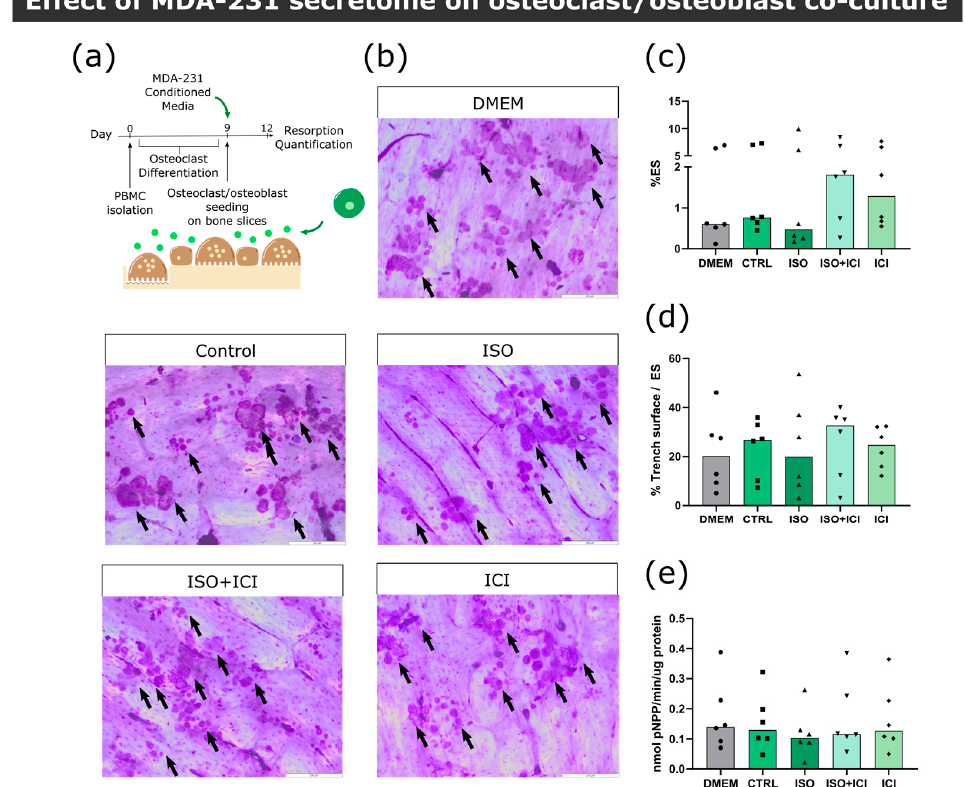
Figure 4. Effect of MDA-231 secretome on osteoclast/osteoblast co-culture. ( a ) Timeline of the resorption assay in a co-culture setting. Mature osteoclasts were seeded with osteoblasts and exposed to MDA-231 conditioned media for three days. ( b ) Representative micrographs of the surface of bone slices after three days of resorption in co-cultures. Resorption events are highlighted by black arrows. Scale bar—200 µ M. ( c ) Estimated percentage of eroded surface, ( d ) trench percentage per total eroded surface and ( e ) TRAcP activity quantified at the end of the co-culture experiment. Data are expressed as the median of individual data points from six independent experiments (Friedman’s test followed by Dunn’s multiple comparison test, * p ≤